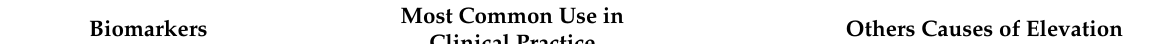
Table 1. Clinical situation causing elevation of biomarkers in the